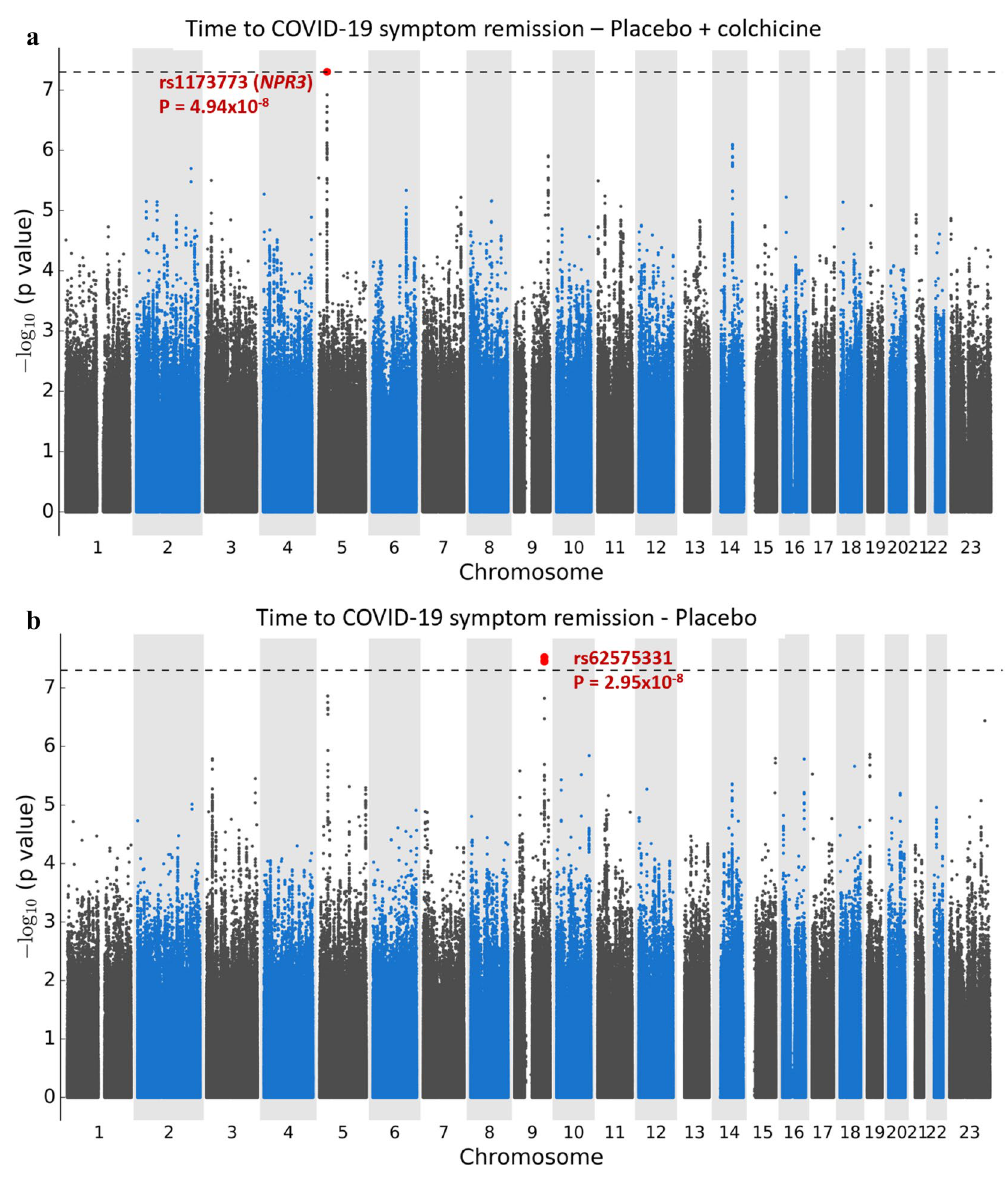
Figure 1. Manhattan plots for the GWAS of time to remission of COVID-19 symptoms. ( a ) Using a Cox proportional hazards regression with 1723 subjects from the colchicine and placebo arms of the COLCORONA study, controlling for study arm, sex, age, and 10 principal components for genetic ancestry, with 6,392,715 genetic variants of minor allele frequency ≥ 5%. ( b ) Using a Cox proportional hazards regression with 851 subjects from the placebo arm of the COLCORONA study, controlling for sex, age, and 10 principal components for genetic ancestry, with 6,390,776 genetic variants of minor allele frequency ≥